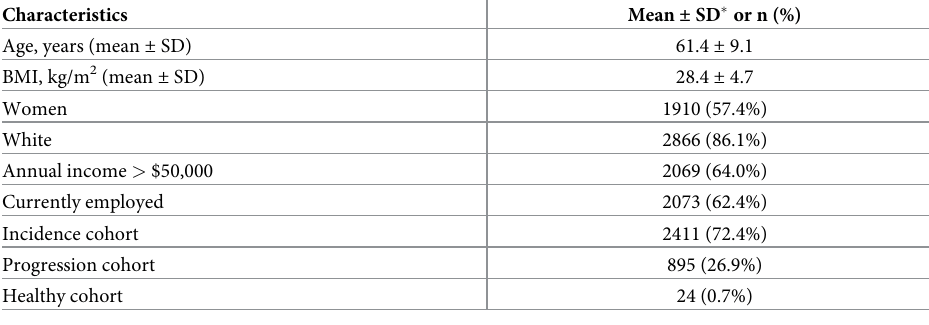
Table 2. Characteristics of included individuals from the OAI baseline cohort (n = 3330).